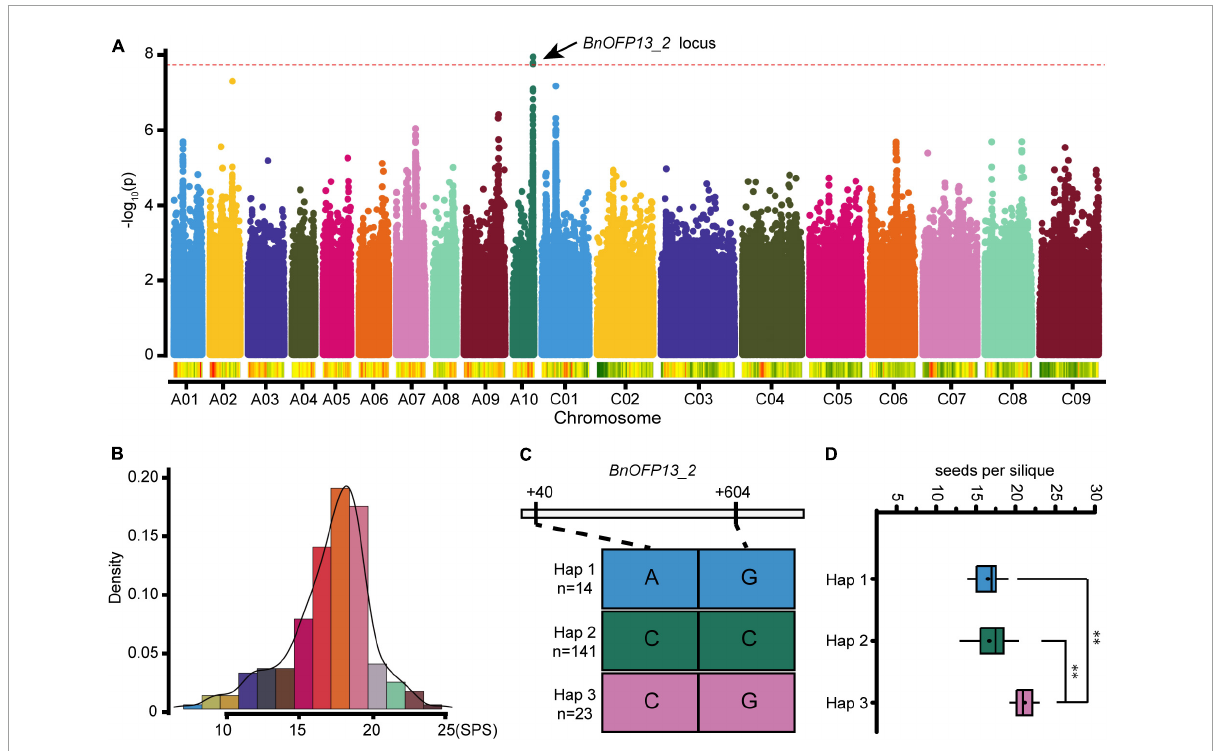
FIGURE6 Genome wide association study (GWAS) and haplotype analysis. (A) Manhattan map of GWAS. The red dotted line represents the threshold value 7.72. Dots above the red dotted line indicate the significant loci associated with NSPS. (B) Histogram of frequency distribution. Statistical analysis of NSPS phenotype used in GWAS. Phenotype variations of 204 accessions are presented. (C) Haplotype analysis of BnOFP13_2 . All the accessions were classified into three haplotypes based on the two non-synonymous SNPs of BnOFP13_2 . (D) Haplotype analysis. Statistical analysis of accessions in each haplotype, and the phenotype value shows significant differences. ** p < 0.01 in ANOVA